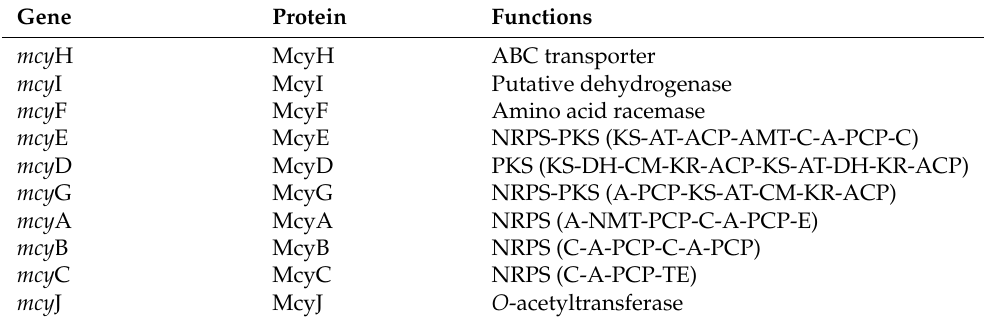
Table 2. The mcy operon involved in the biosynthesis of microcystins by cyanobacteria. Gene Protein